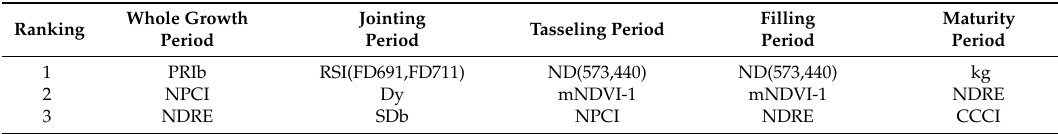
Table 5. The top 20 spectral indexes in each growth